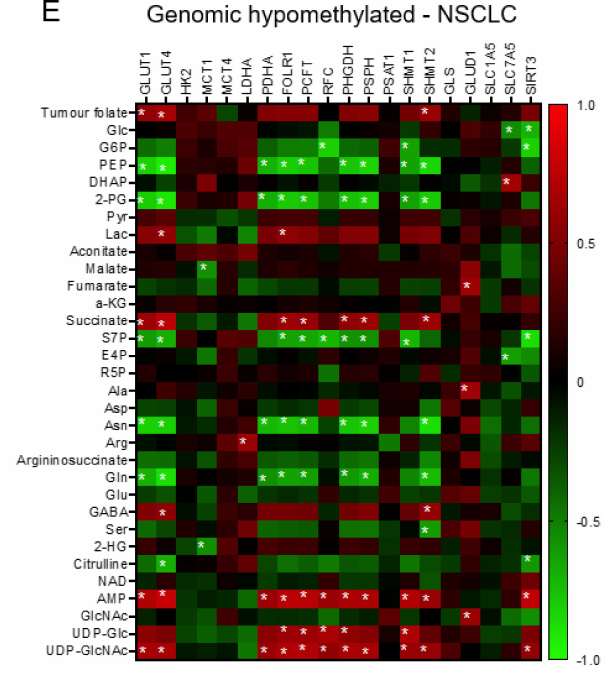
Figure 5. The interactive network of metabolites and genetic signatures modified by advance stage and clinical folate trait in NSCLCs. The correlation heat map was constructed for ( A ) advance stage-NSCLC; ( B ) low tumour folate-NSCLC (< media tumour folate); ( C ) low plasma folate-NSCLC (< median blood folate: 5.5 µ g/mL); ( D ) low dietary folate intake-NSCLC (media intake: 497 µ g/day); and ( E ) genomic DNA hypomethylation ( LINE1 methylation < 66%). The Pearson coefficient correla- tion was considered to be statistically significant at * p <